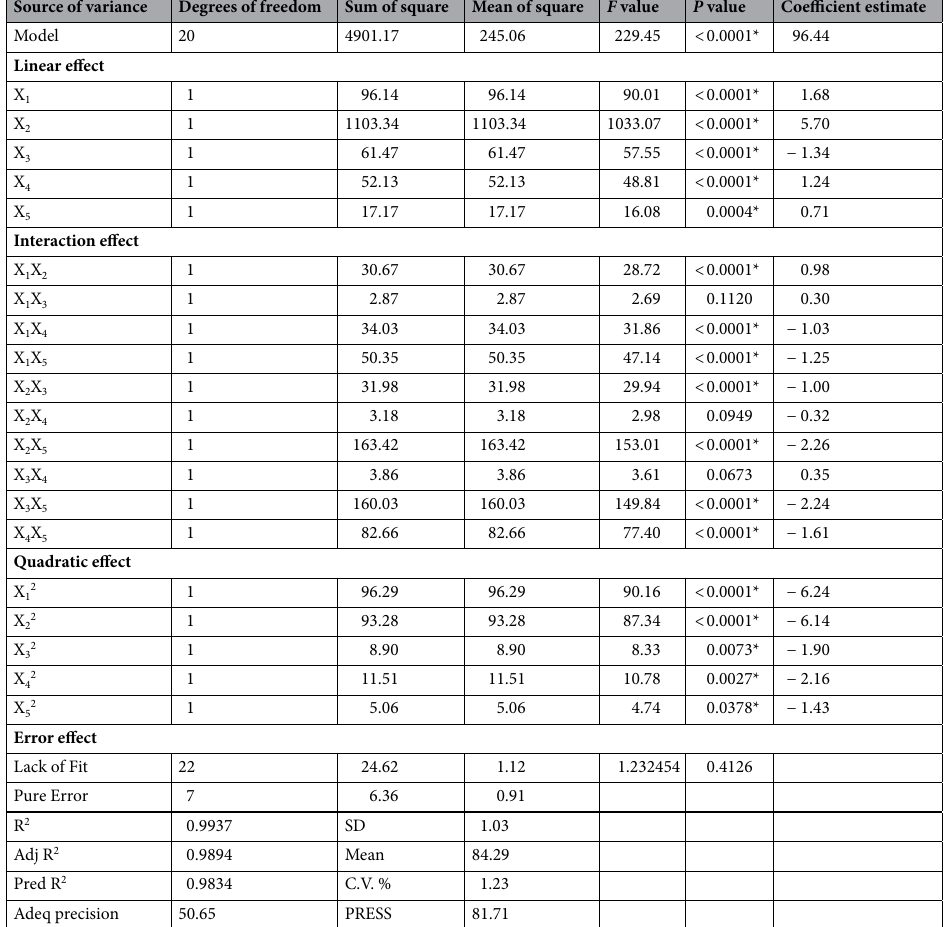
Table 3. Analysis of variance for biosorption of Hg 2+ by Gelidium corneum biomass obtained by FCCCD. F Fishers’s function, P level of significance, C.V coefficient of variation. *Significant values.